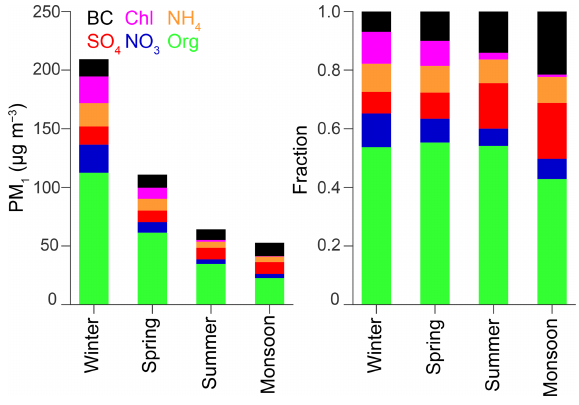
Figure 3. Average absolute and fractional composition of PM 1 (Org, Chl, NH 4 , NO 3 , SO 4 , and BC) by season. Limited BC data for the monsoon due to instrument